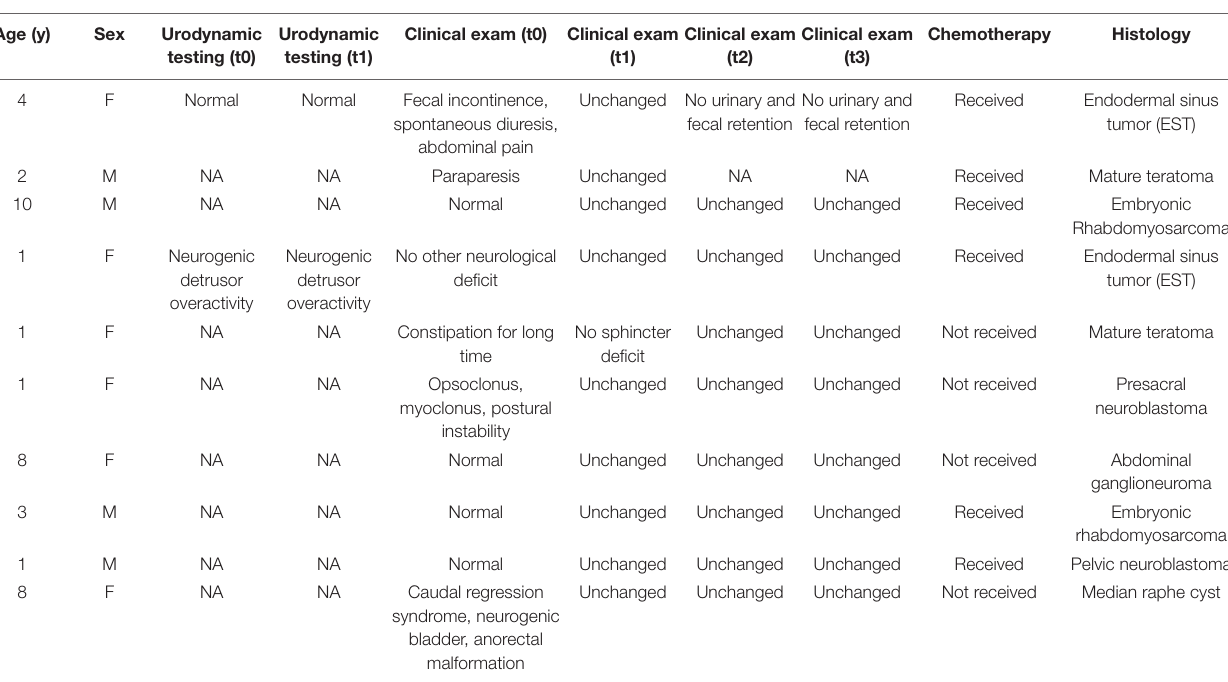
TABLE 1 | Demographic and clinical